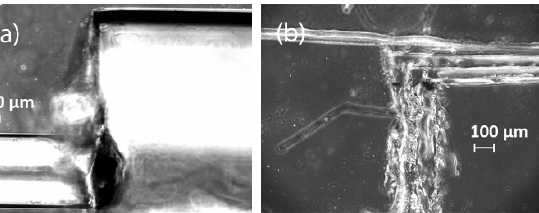
Figure 7. Microfluidic chip from capillaries ( a ) and adhesive tape ( b ) at 10× magnification.